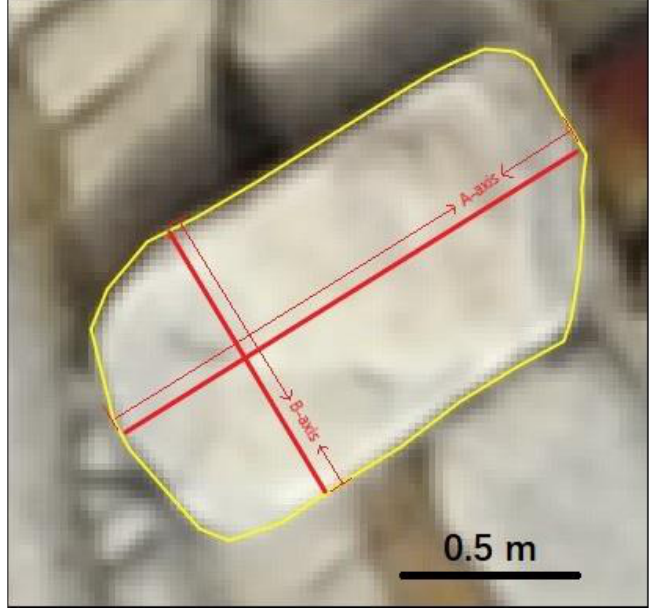
Figure 4. ( a ) M3C2 distance at different locations. Red and black circles represent the point clouds of the same region for two different years. The M3C2 values in the boulder-moving areas were significantly larger than those in unchanged areas. ( b ) The method used to determine the height ( dh ) of the polygon column. This is a side view of the M3C2 output, which is a point cloud comprised of core points (2018 point cloud with RGB information removed and M3C2 results added). The red, blue, and black circles indicate the core points where the M3C2 values were significantly above 0 (boulder appears), far below 0 (boulder disappears), and approaching 0 (no change), respectively. 5. Calculating the boulder volume. The volume of each polygonal column was ex-